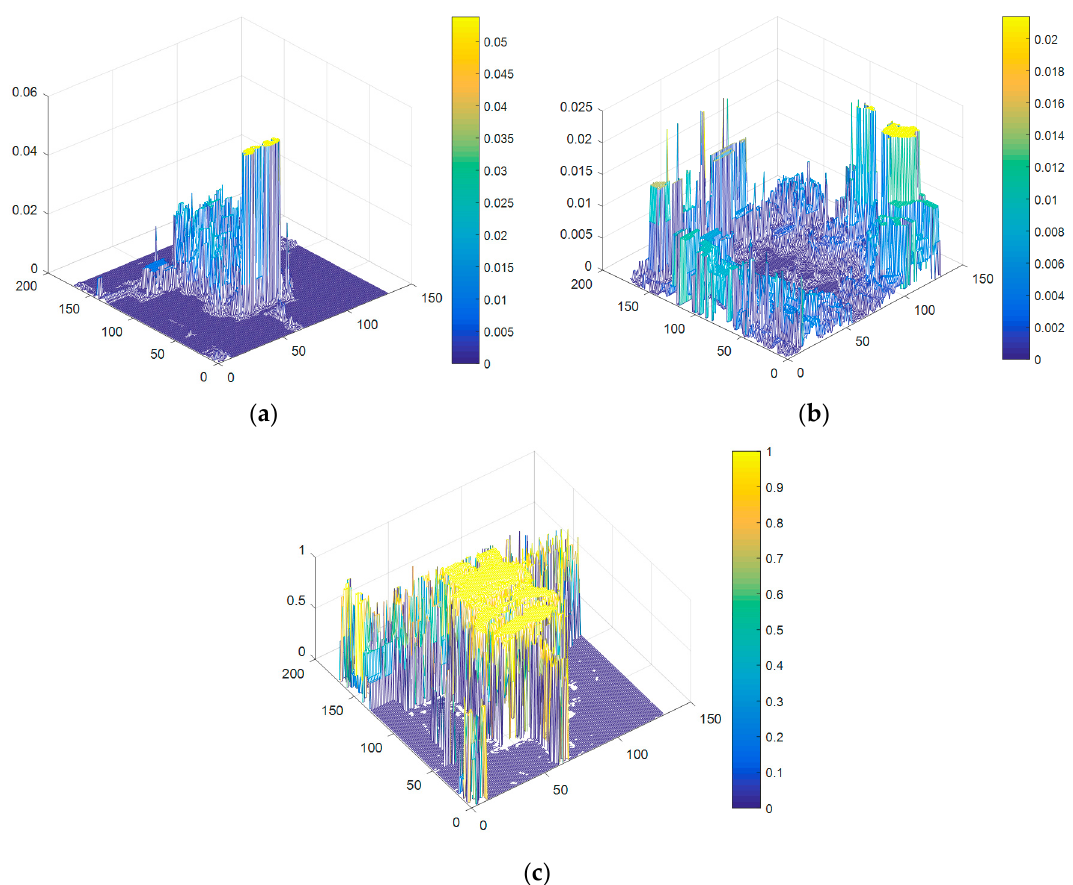
Figure 3. The color histograms of the lemming sequence in frame 138: ( a ) The color histogram of H O ( b x ); ( b ) The color histogram of H B ( b x ); ( c ) The color histogram of P ( x ∈ O | O , B , b x